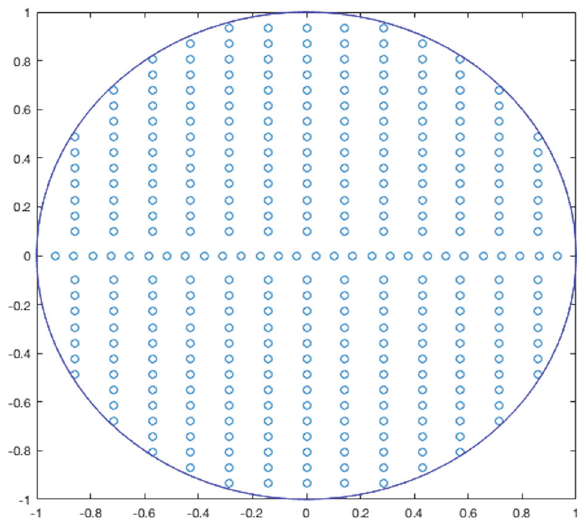
Fig. 10 Discretization of a unit circle provides an example of gridding the unit circle used in the